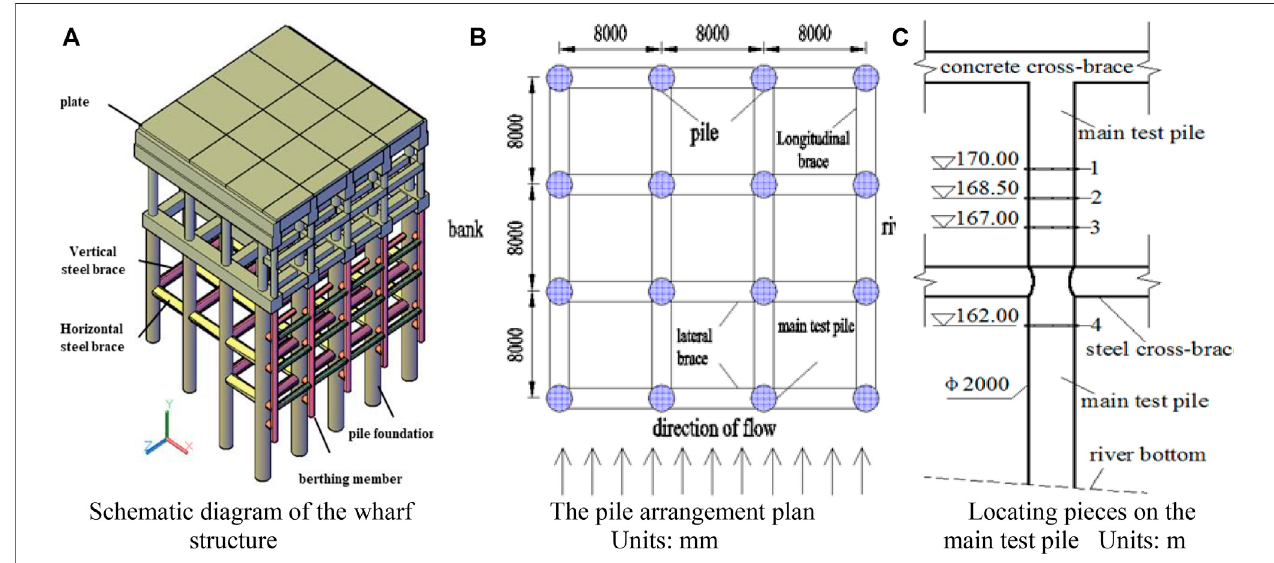
Frontiers in Environmental Science |